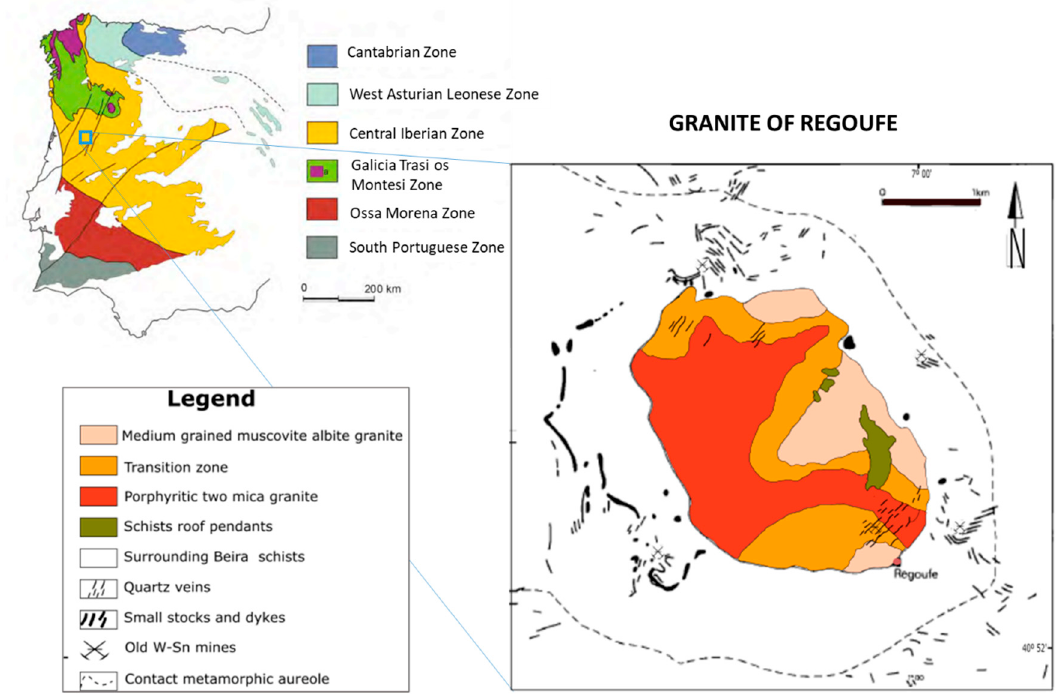
Figure 1. Geological sketch of the Central Iberian Zone modified with the location of the study area and its geological map, modified from [31,32].